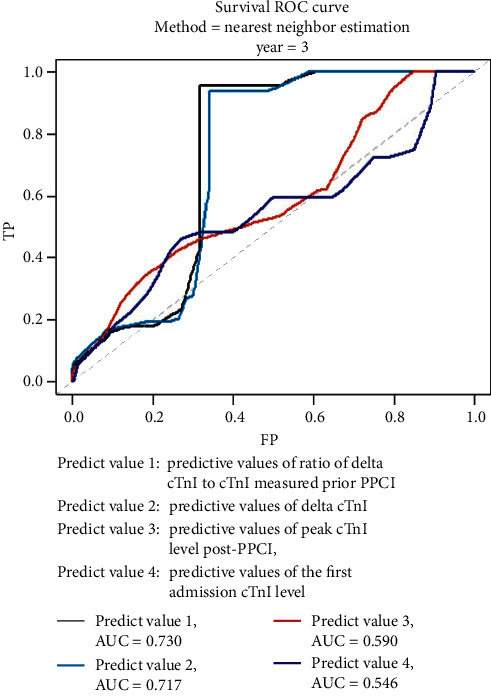
Survival ROC curve. Predictive value 1: predictive values of ratio of delta cTnI to cTnI measured prior PPCI; predictive value 2: predictive values of delta cTnI; predictive value 3: predictive values of the peak cTnI level after PPCI; and predictive value 4: predictive values of the first admission cTnI level. Survival receiver operating characteristic curves for a model including the ratio of delta cTnI to cTnI measured prior PPCI (black line), △cTnI level (wathet blue line), peak level after PPCI (red line), and cTnI concentrations at admission (dark blue line). The areas under the ROC curve are shown for the graph. AUC, area under the curve; ROC, survival receiver operating characteristic; TP, true positive; and FP, false positive.